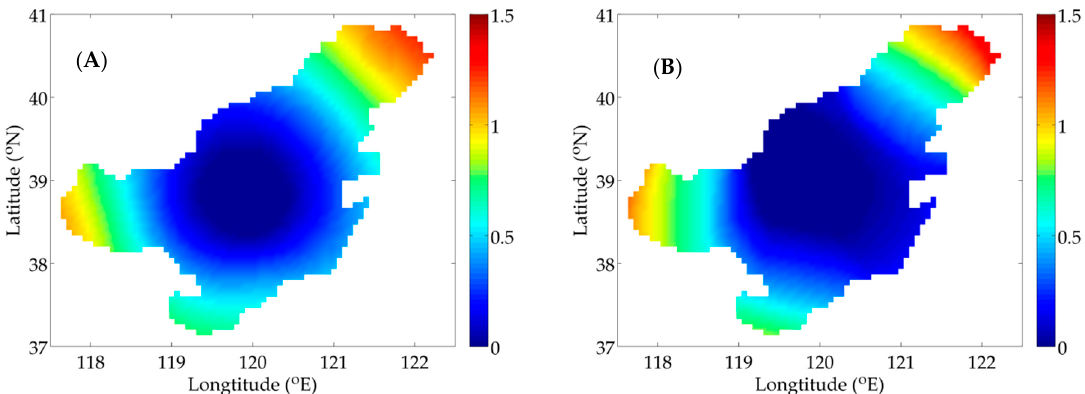
Figure 4. Distributions of P inverted with the adjoint method combined with the spline interpolation (SI) ( A ) and the Cressman interpolation (CI) ( B ) in IE1 (unit: mmol N m − 3 ). Table 2. The results of the quantitative metrics using two interpolation methods in the idealized twin experiment 1